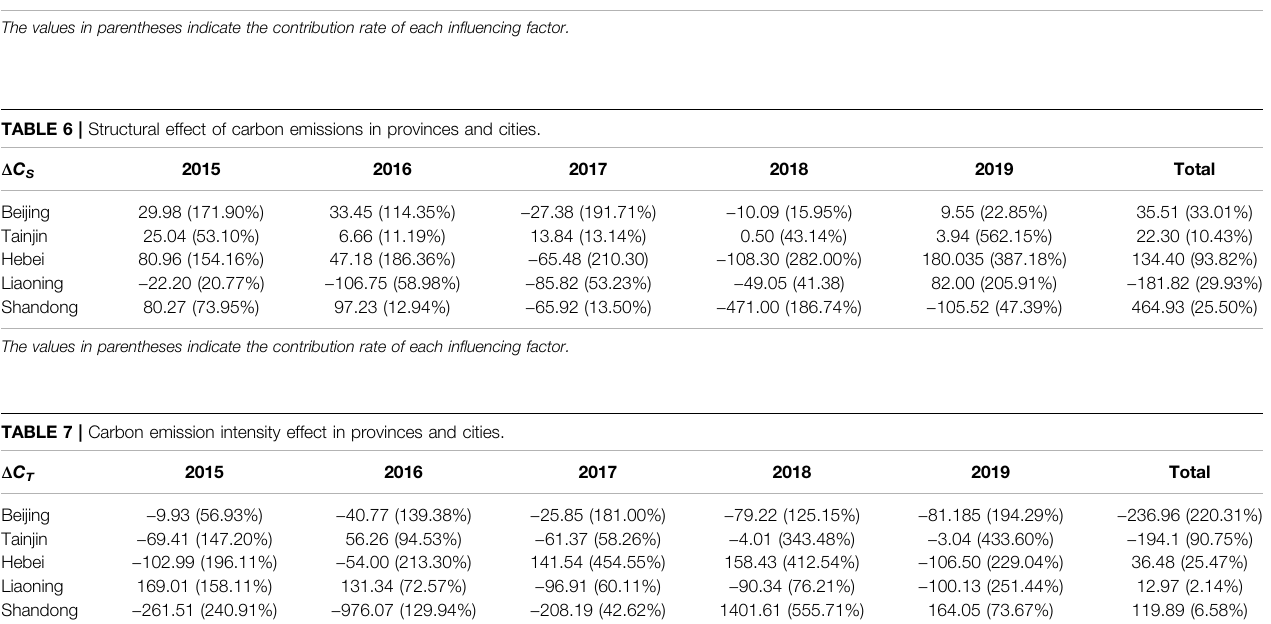
The values in parentheses indicate the contribution rate of each in fl uencing factor.